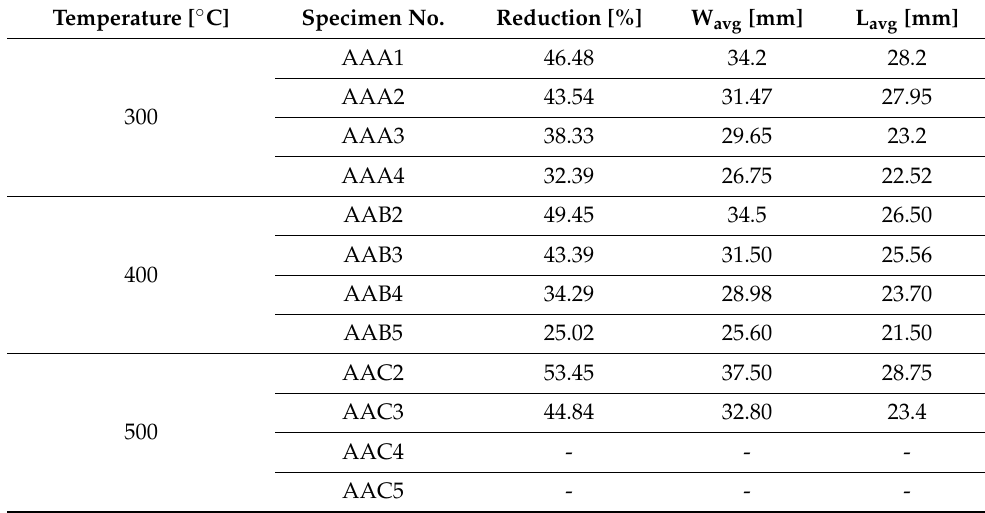
Table 2. Compression bonding experimental parameters and dimensions of the specimens after the